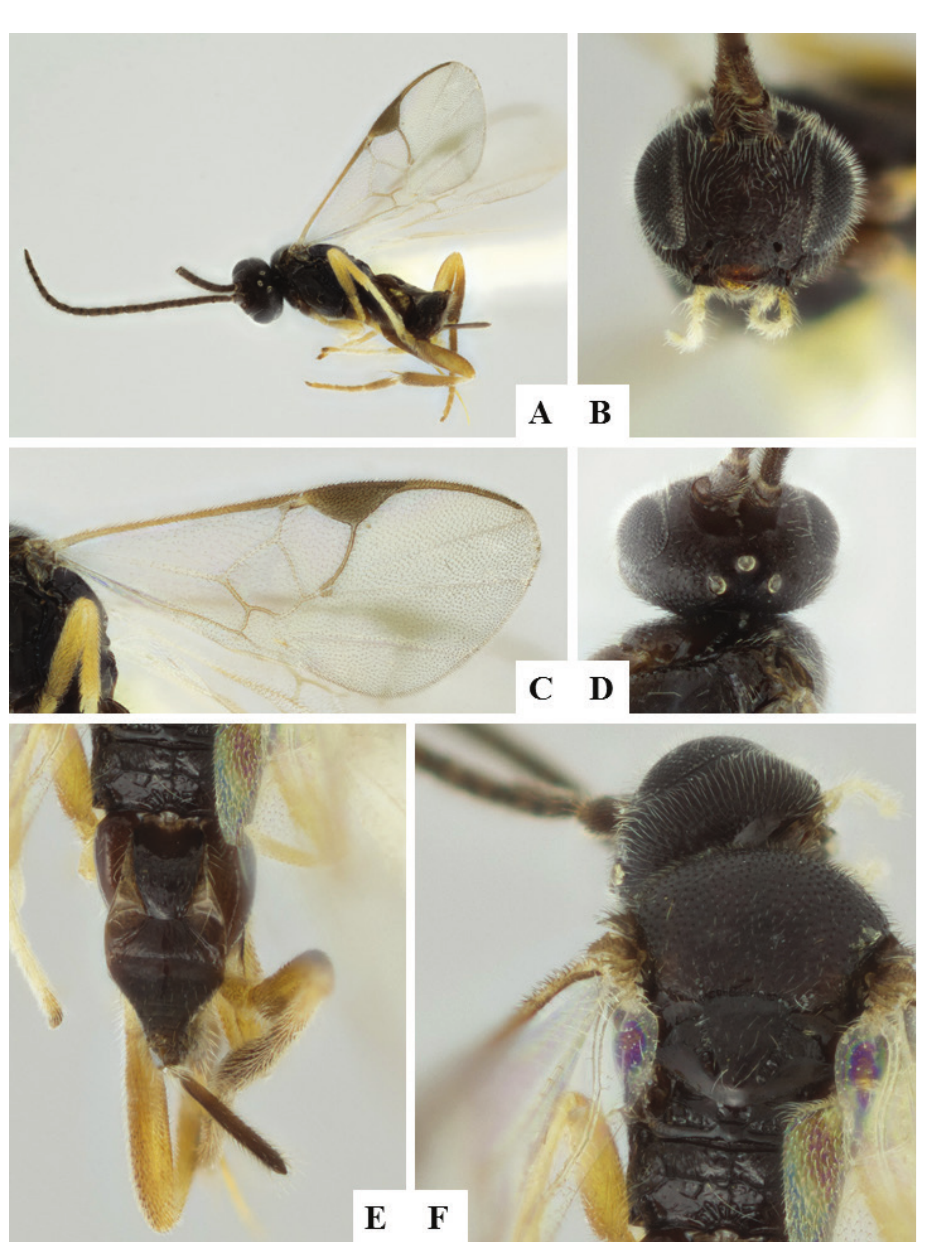
Figure 13. Clarkinella canadensis. A Habitus, lateral B Head, frontal C Wings D Head dorsal E Meta- soma, dorsal F Head and mesosoma,